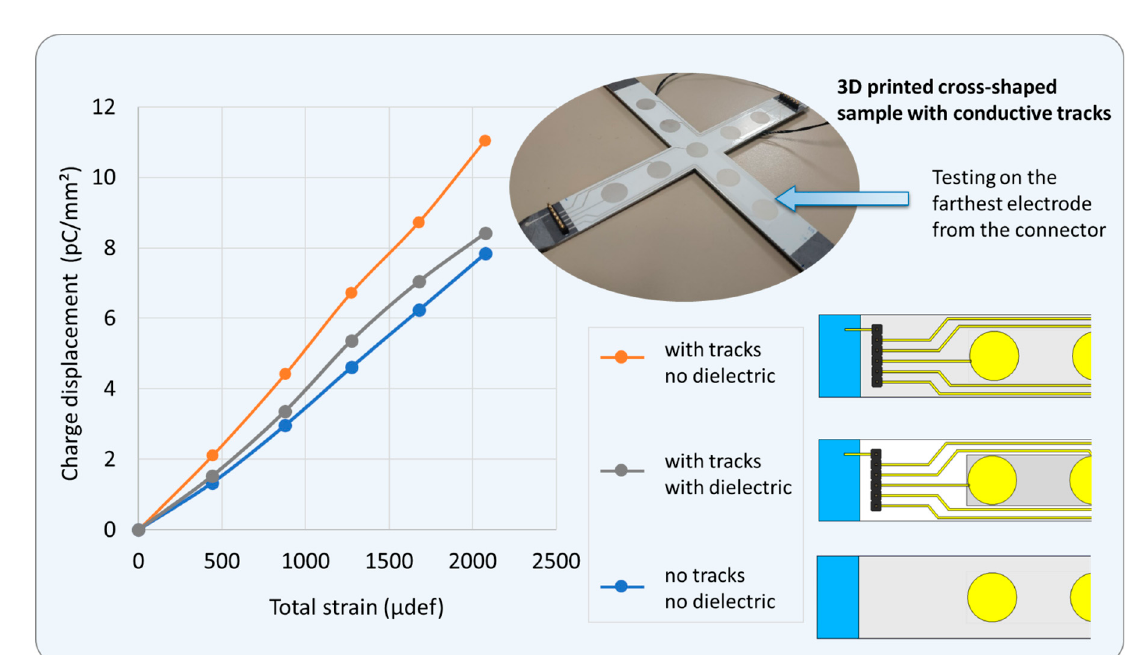
Figure 11. Piezoelectric response of three tested samples with or without conductive tracks (CTs) and dielectric layer. Measurements were performed on peripherical electrode that has the longest CT.